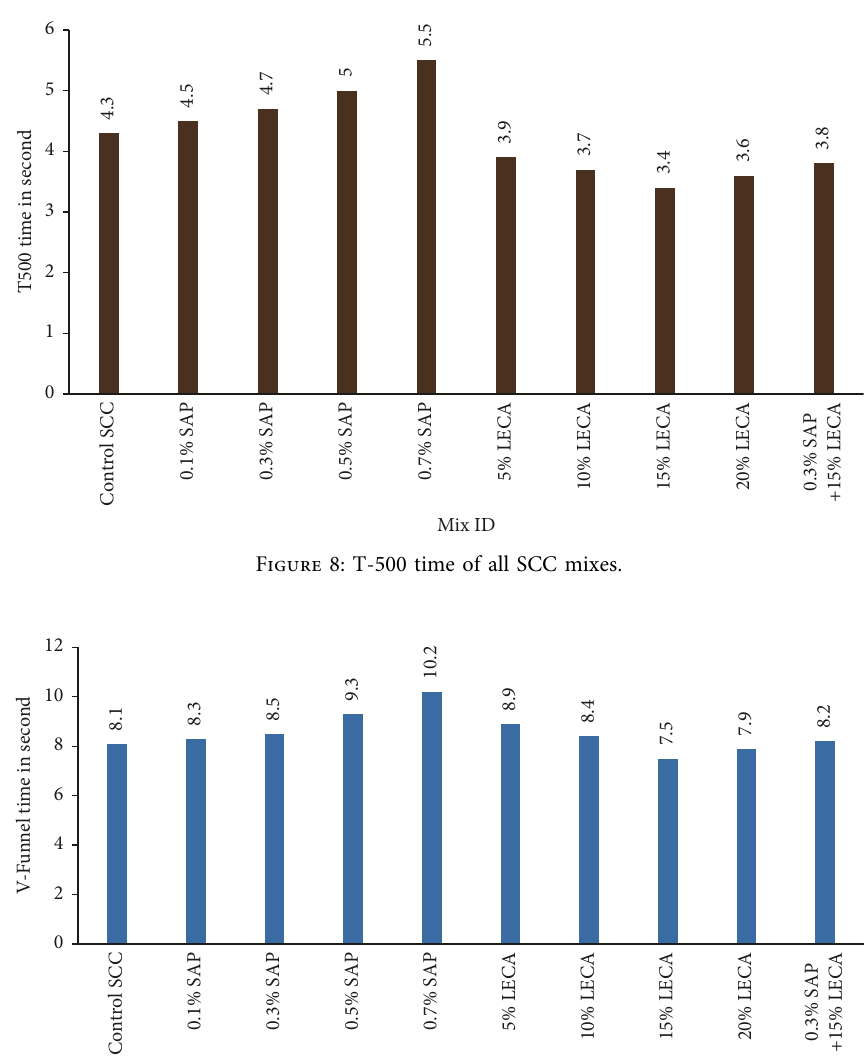
Figure 9: V-funnel time of all SCC